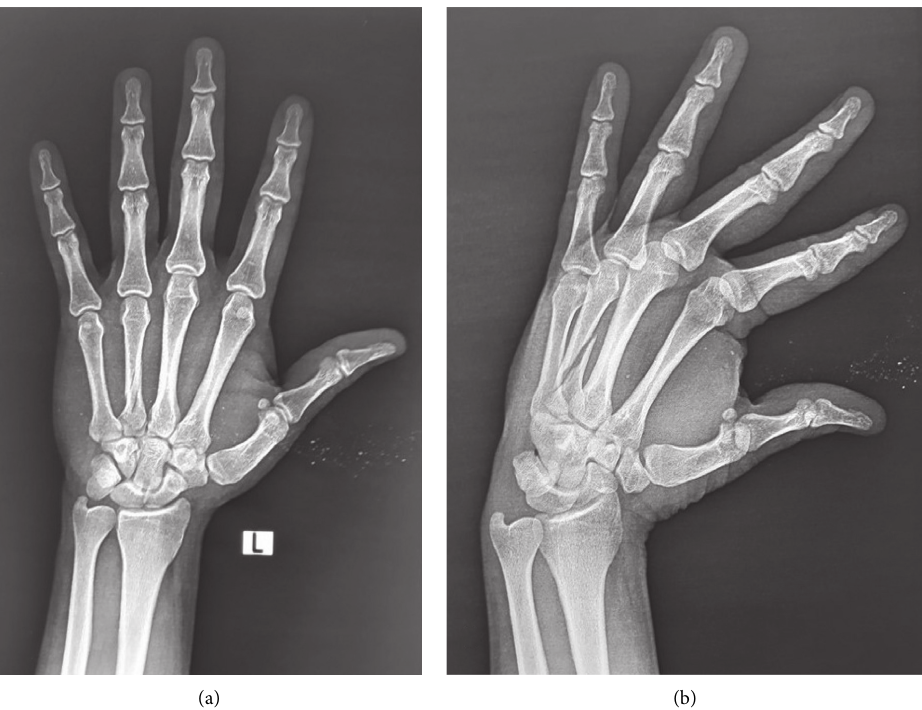
Figure 1: A 30-year-old male patient with spiral fracture at the fourth metacarpal: the medulla of the second and third metacarpal bones is too narrow, while the medulla of the fourth metacarpal is patent which allows intramedullary